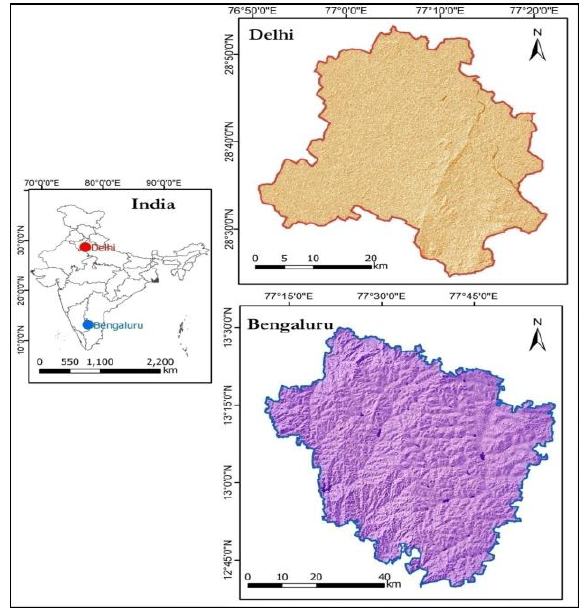
Figure 1. Study area location and extend.